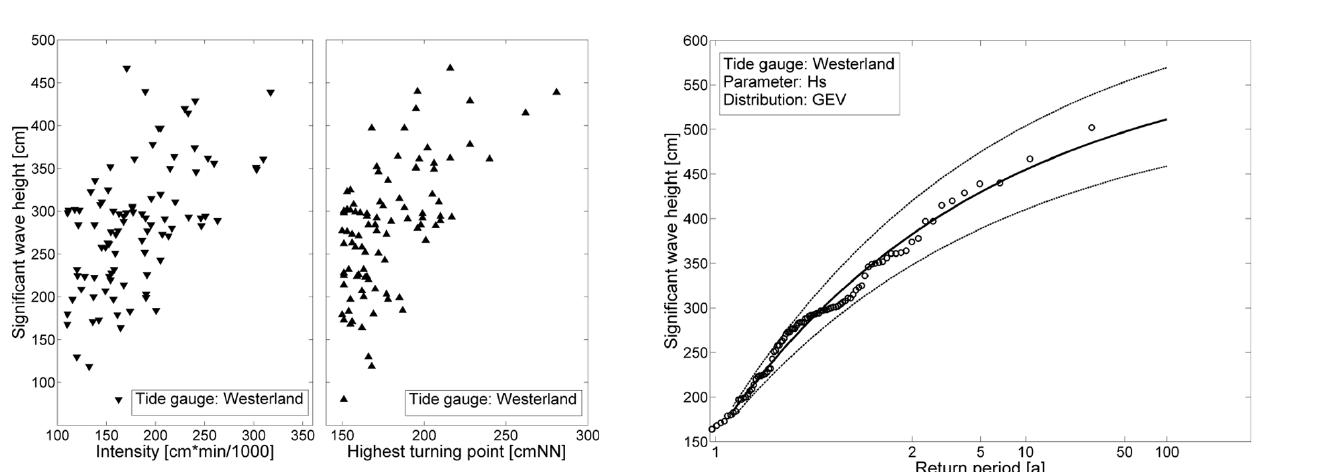
H s based on a GEV (with 95%-confidence